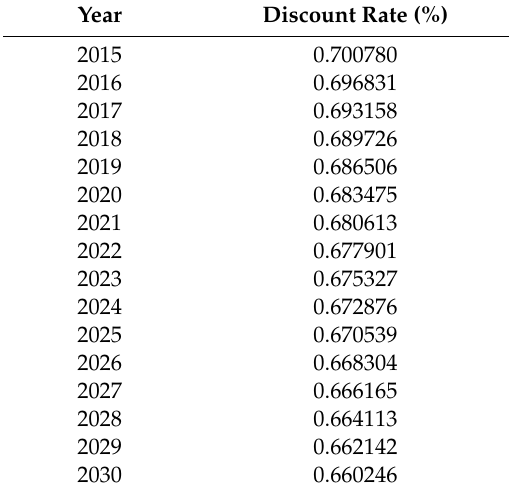
Table 9. Discount rates (due only to the hazard rate) from the global discount function (for National Forests and the rest of forests) for the period of 2015 to